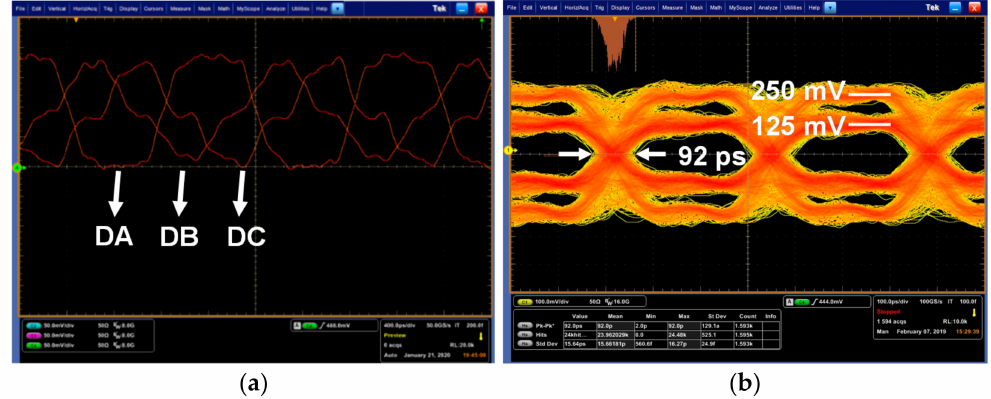
Figure 16. Measured waveforms of MIPI C-PHY signals transmitted from transmitter: ( a ) Pre- determined data for ALDE; ( b ) Eye diagram of MIPI C-PHY